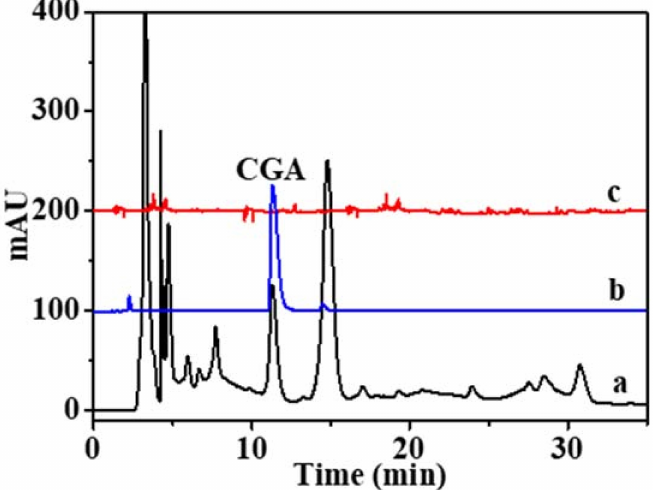
Figure 5. HPLC chromatograms of Duzhong brick tea extract. ( a ) The chromatogram of initial Duzhong brick tea extract; ( b ) The chromatogram of elution of CGA after extracted with MPMIPs; ( c ) with